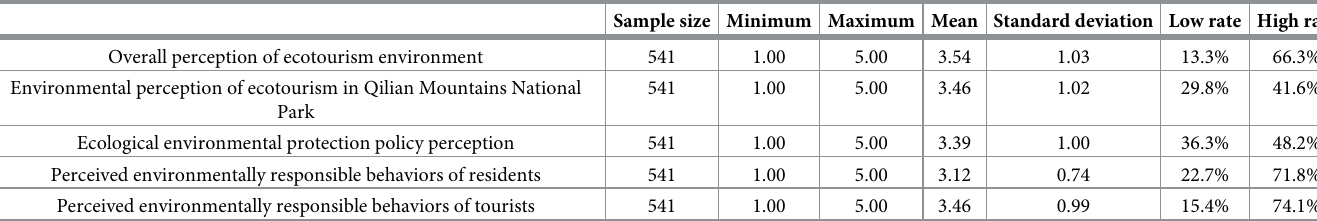
Table 12. Statistical analysis chart of tourist scale.